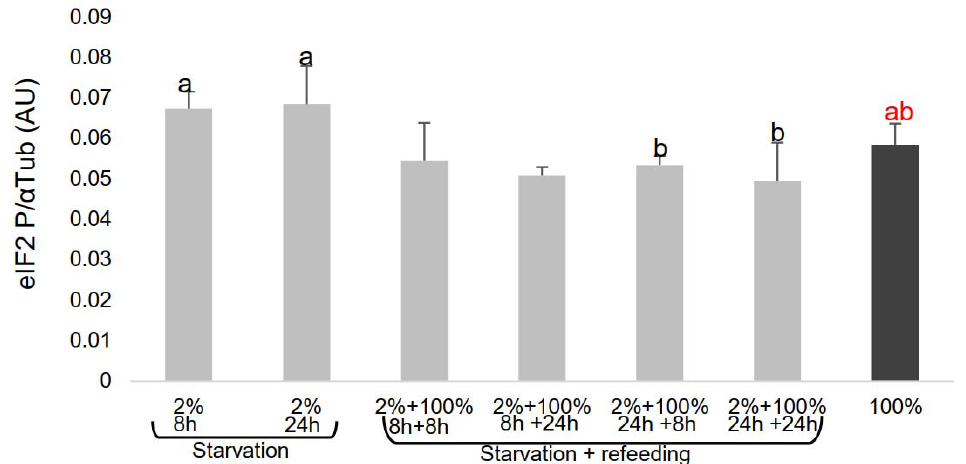
Figure 3. Total and phosphorylated eIF2 expression in MECs cultured for 6 days. EAAs were added